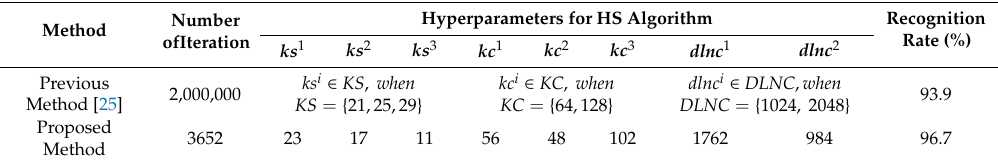
Table 9. Number of iterations required for hyperparameter optimization and recognition rate using optimized